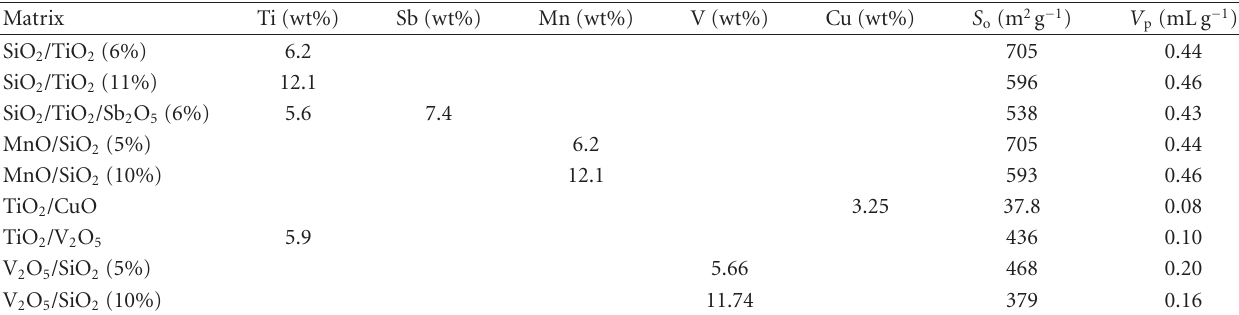
Table 1: Chemical analyses (XRFS), specific surface area ( S o ), and pore volume ( V p ) of the mixed